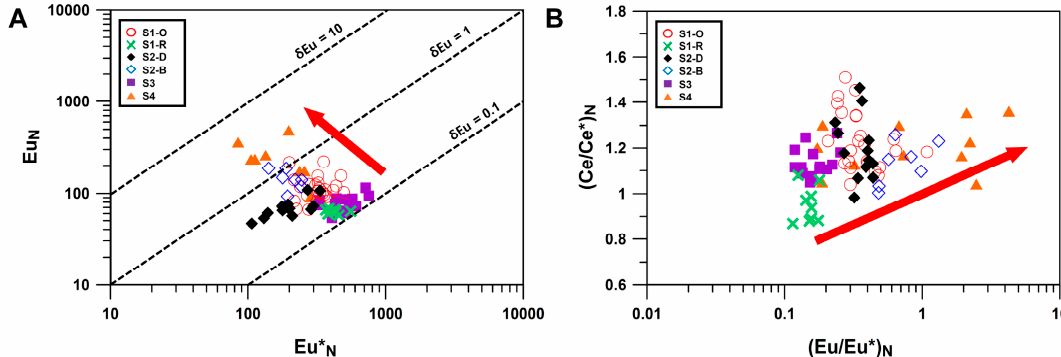
Figure 10. ( A ) Plot of chondrite normalized Eu concentrations (Eu N ) versus calculated Eu* N . Dashed lines represent δ Eu (Eu N / Eu* N ) isolines for 0.1, 1, and 10. Increasing δ Eu value means predominance of Eu 2 + , shifting into positive Eu anomaly. ( B ) Plot of δ Eu versus δ Ce (Ce N / Ce* N ), when Ce* N is value of (La N × Pr N ) 1 / 2 . δ Ce roughly increases as δ Eu increases from earlier stage to later stage. Increasing Ce anomaly indicates that the system changed into a more reduced environment.